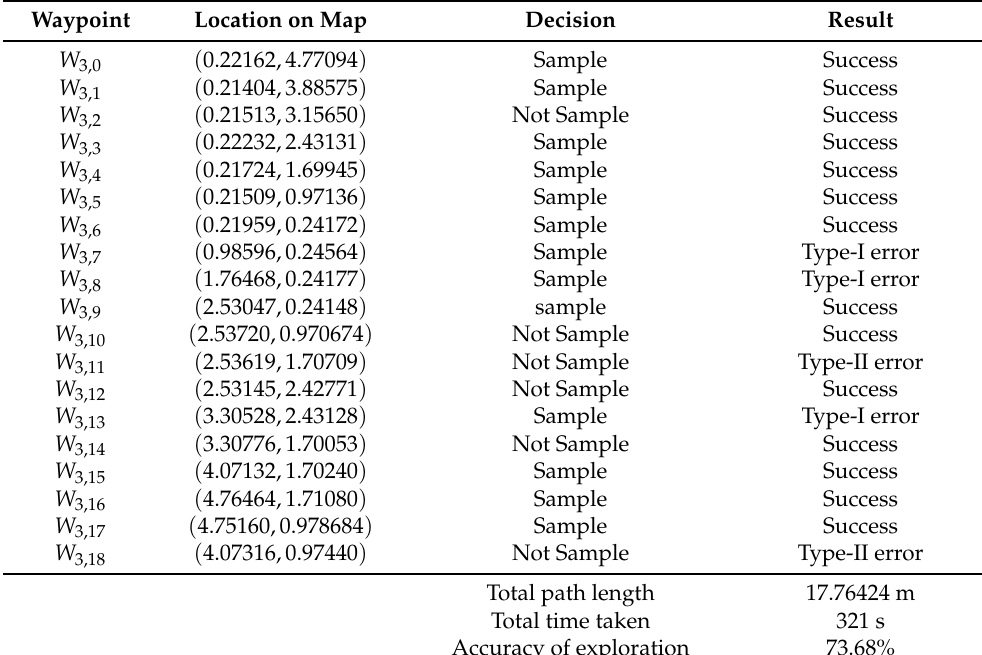
Figure 12. The explored path and estimated dirt density hot-spots in trial-1 ( a ), trial-2 ( b ), trial-3 ( c ) and trial-4 ( d ). Table 5. The list of locations visited by the robot in trial-3 and sampling decision